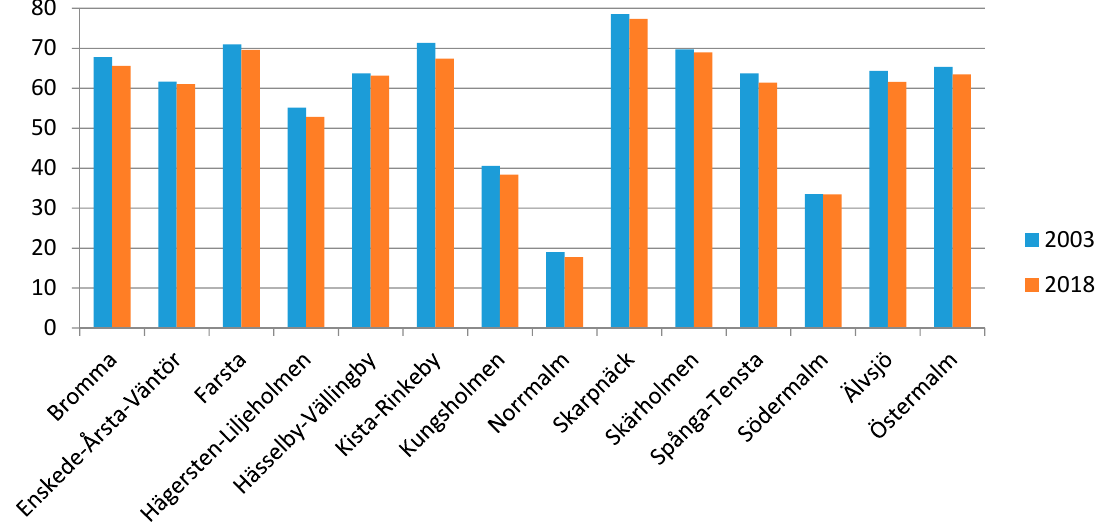
Figure 5. Change in green area percentage per district in Stockholm City between 2003 and 2018. Table 3. Urban and green area changes per district.